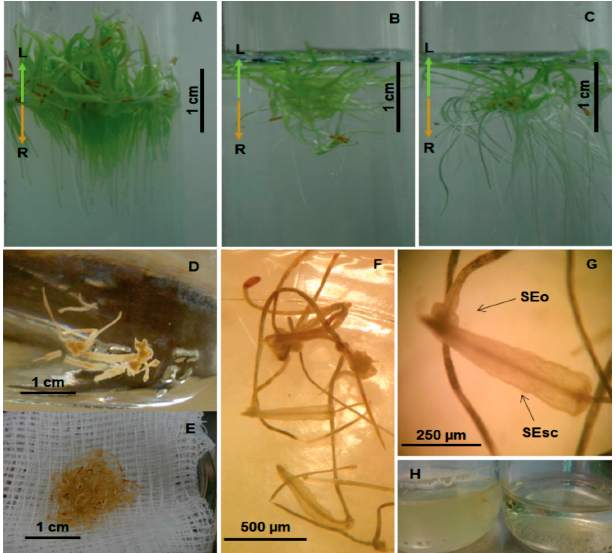
Figure 2. Induction of somatic embryos on rhizoclones from T. domingensis seedlings. Induction started with the in vitro germination of T. domingensis seeds in rhizotron systems with MS0.1 semisolid ( A ) or liquid ( B ) culture medium or with sterile purified water alone ( C ) for the establishment of rhizoclones for the induction of somatic embryos ( D ), harvested from single cultures ( E ). Those embryos showing scutellar (SEsc) and oblong (SEo) morphological stages ( F , G ) were transferred into a suspension of A. rhizogenes ( H ) for genetic transformation by agrotransfection. The arrows show the magnification of each somatic embryo in G imagen. L = Leaf, R =